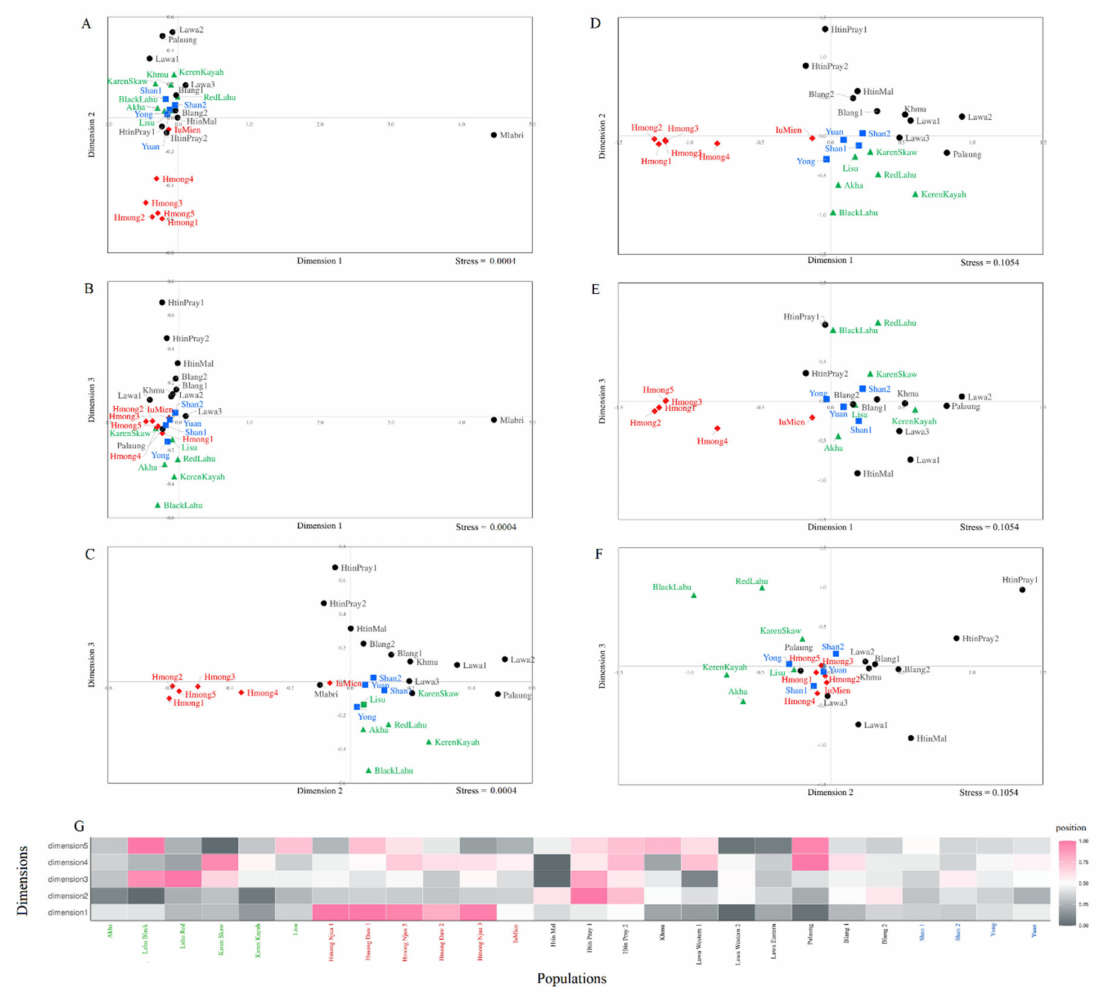
Figure 3. The three-dimensional MDS plot of dimension 1 vs. 2 ( A ), 1 vs. 3 ( B ) and 2 vs. 3 ( C ) of total 27 populations. The three-dimensional MDS plot of dimension 1 vs. 2 ( D ), 1 vs. 3 ( E ) and 2 vs. 3 ( F ) of 26 populations, after excluding Mlabri. The heat plot of standardized values of MDS with five dimensions ( G ). Red diamonds, green triangles, black circles, and blue squares represent HM-, ST-, AA-, and TK-speaking populations,